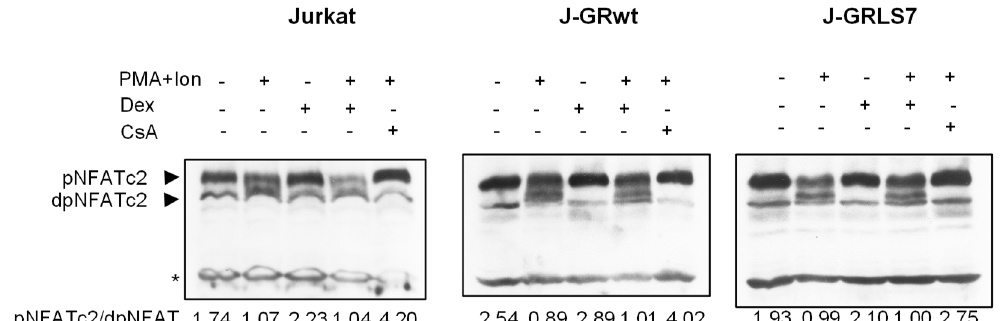
Figure 5. Dex treatment does not disturb NFAT dephosphorylation. Western blot analysis of NFATc2 in total protein extracts from parental, J-GRwt, or J-GRLS7 Jurkat cells pre-treated or not with Dex (1 μ M) or CsA (100 ng/mL) before stimulation with PMA +Ion for 90 min. Bands of phosphorylated (p-) and dephosphorylated (dp-) NFATc2 are indicated by arrows. Nonspecific bands (marked by an asterisk) are also shown as internal loading control. The ratio of phosphorylated vs. dephosphorylated NFATc2 was determined by quantification of the respective bands and it is shown under each lane.